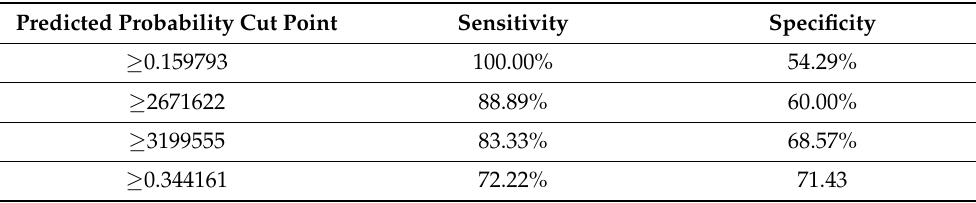
Table 10. Final Advanced Stage EC patients vs. controls model: sensitivity/specificity plot for the resulting multivariate logistic regression model for sensitivity levels higher than specificity levels.